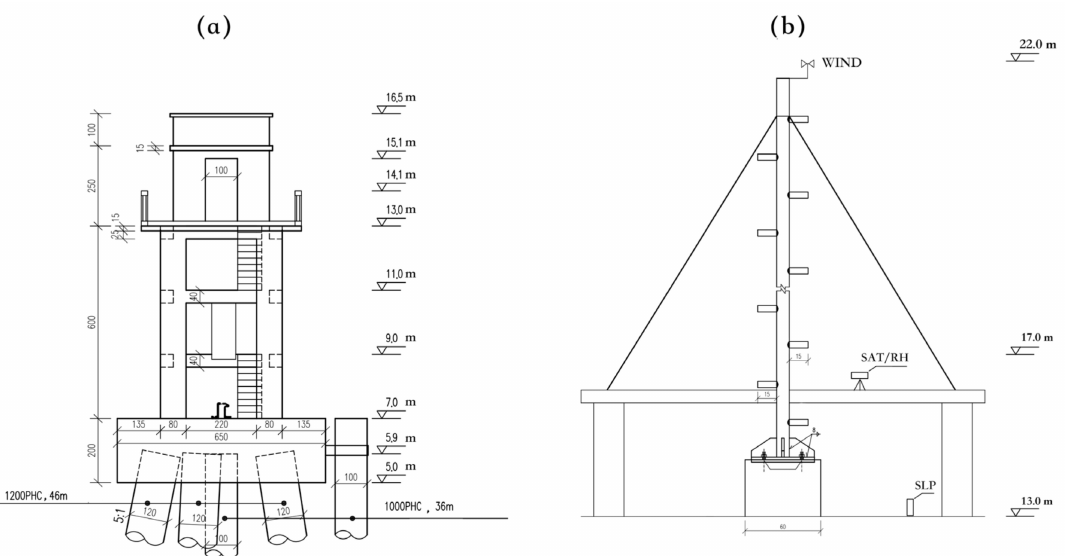
Figure 2. The plan-view architecture of the platform ( a ) and the observational air-sea parameter sensors ( b ). Note that the numbers followed by units are in meters, but those without units are in centimetres. Detailed information on the observational heights of the sensors is listed in Table